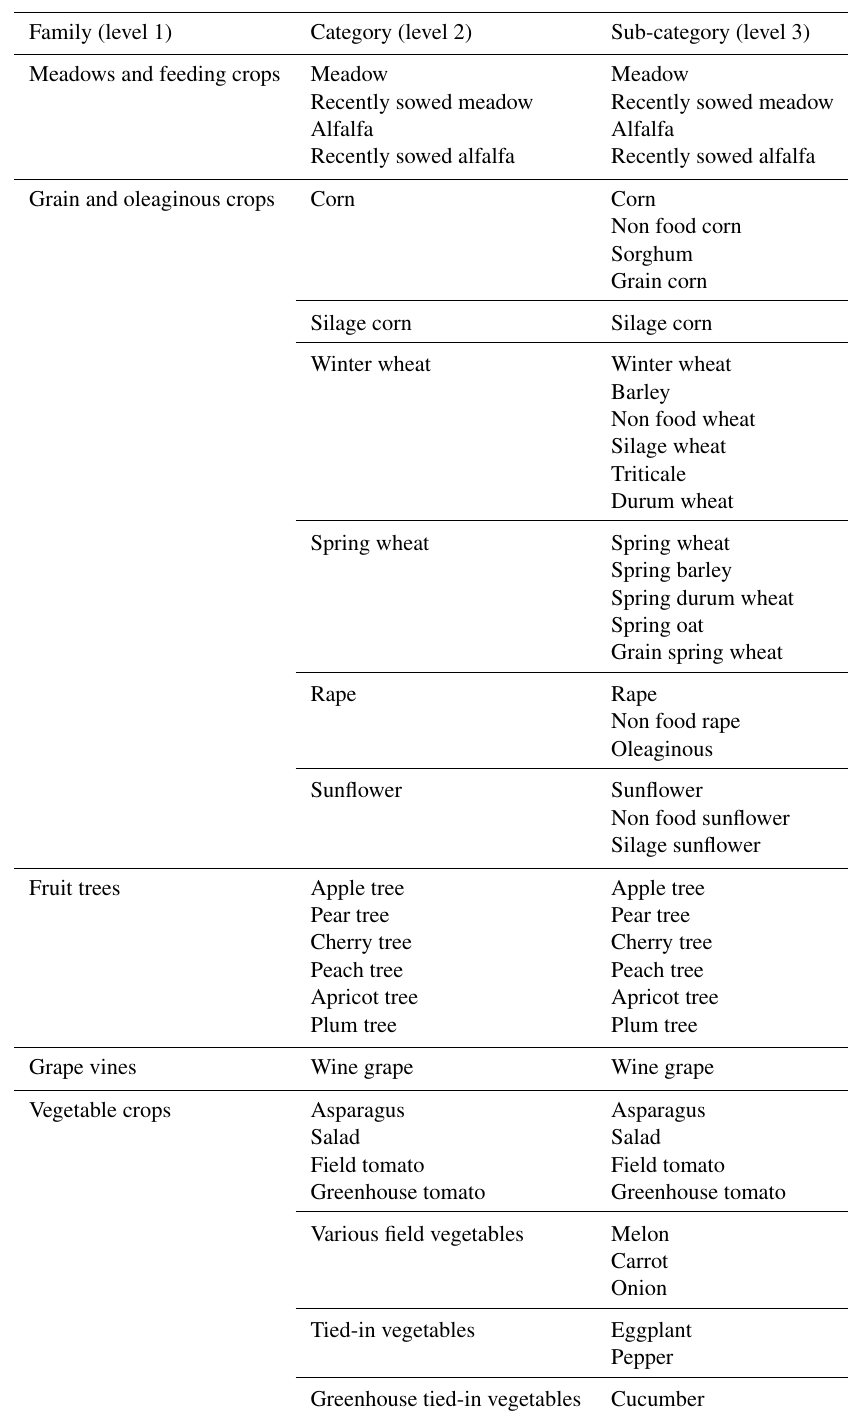
Table A1. Families and categories of crops considered in